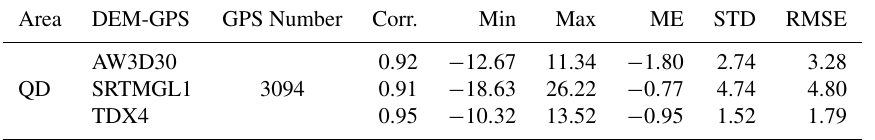
Table 2. Absolute accuracy for TDX DEM in Qingdao